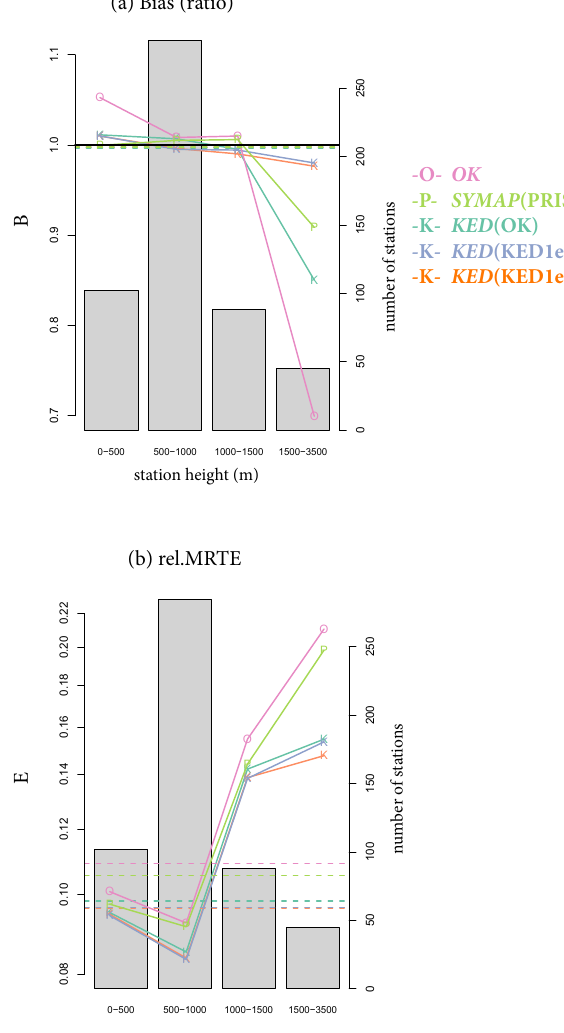
Figure 9. Error statistics for the interpolation of daily precipita- tion in winter (DJF, 1971–2008) using the interpolation models of Table 2 (see also Sect. 3). (a) Relative bias B (dimensionless, Eq. 3) and (b) relative mean root-transformed error E (dimension- less, Eq. 4, log scale) of a leave-one-out cross-validation. Results are shown for four elevation classes. Horizontal dashed lines rep- resent the scores over all stations. The vertical bars represent the number of stations per elevation class (right